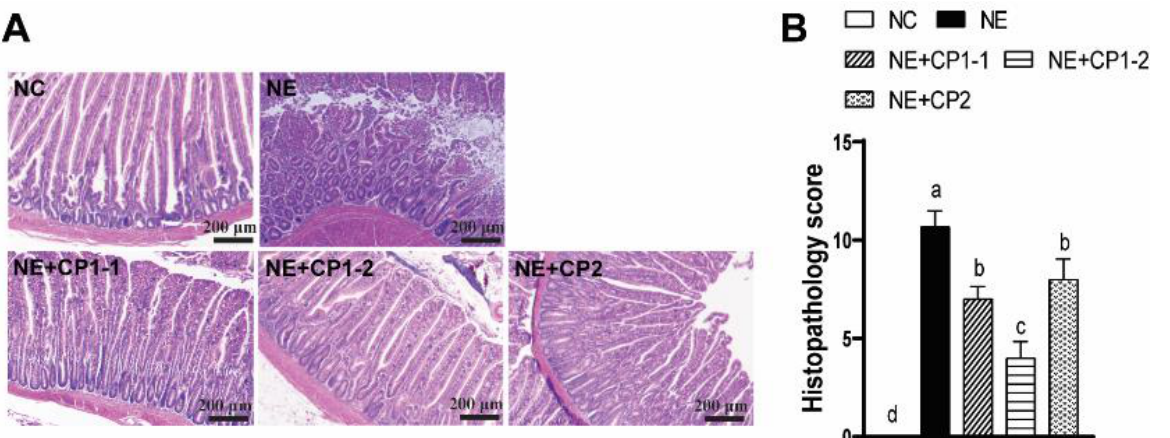
Figure 4. CP-spor-super vaccines protected birds against NE-induced intestinal histopathology. Birds were vaccinated and infected as in Figure 3 and bird numbers at d 21 were NC: 12; NE: 14; CP1-1: 16; CP1-2: 7; and CP2: 7. ( A ) H&E staining showing representative intestinal histology images. ( B ) Quantification of histological intestinal damage score. All graphs depict mean ± SEM. Different letters of a, b, c, and d mean p < 0.05. Results are representative of two independent experiments. Scale bar is 200 μm .